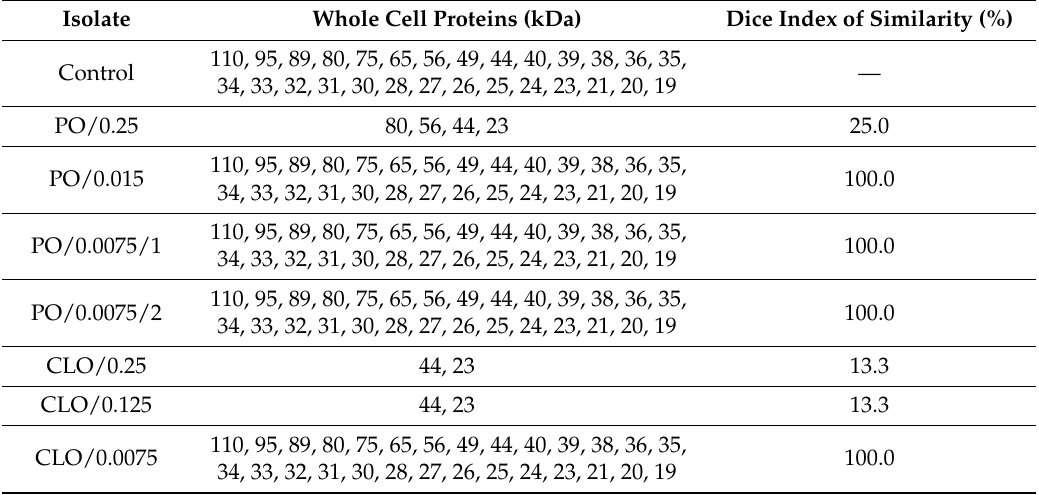
Table 2. Similarity of protein profiles of Candida albicans ATCC 10231 isolates, after treatment with peppermint oil (PO) and clove oil (CLO). Acronyms are composed as follows: essential oil type/oil concentration/isolate number (if